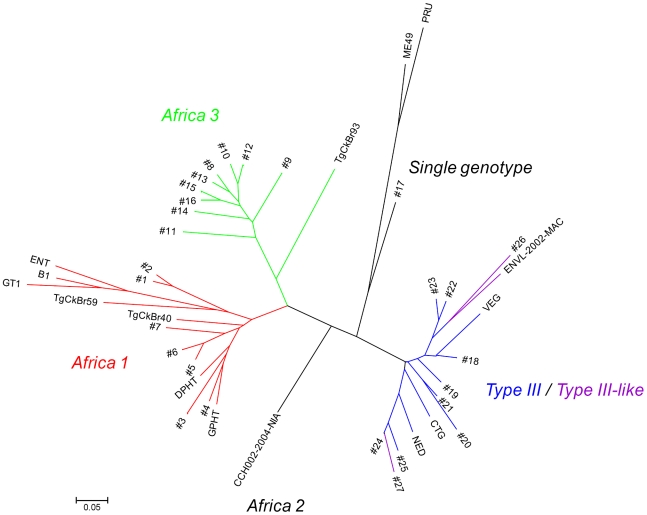
Neighbor-joining tree of genotypes inferred from Cavalli-Sforza distances calculated for the data of 13 microsatellite markers and all 69 Gabonese isolates, including also all the reference strains.[Seven Type reference strains: Type I (GT1, ENT, and B1), Type II (Me49 and PRU), Type III (CTG, VEG and NED), Africa 2 (CCH002-2004-NIA) (Ajzenberg et al. 2009), and Africa 1 (DPHT) (Ajzenberg et al., 2009), and seven reference isolates originating from different countries: France (GPHT), Brazil (TgCkBr93, TgCkBr59, TgCkBr40), and Caribbean islands (ENVL-2002-MAC)]. Note: Midpoint rooting was applied for the Neighbor-joining tree; no outgroup was used. Colors correspond to colors of populations found with STRUCTURE for K = 3 (blue, green and red for respectively cluster C3.1, C3.2 and C3.3 and black for the single isolate strain: GAB4-2007-GAL-DOM1 and for Type reference strains), except for Type III-like isolates which are in purple.